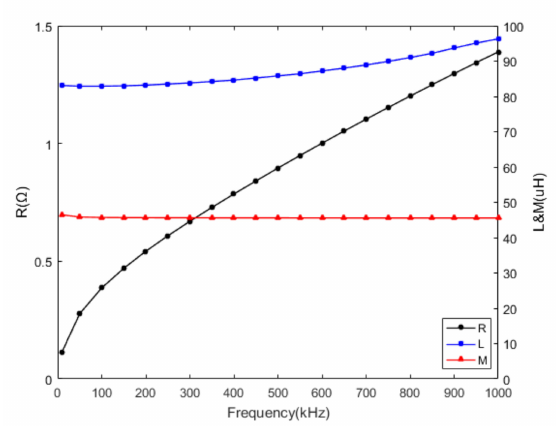
Figure 3. The relationship between coil’s self-inductance L , mutual inductance M , AC resistance R , and frequency f .